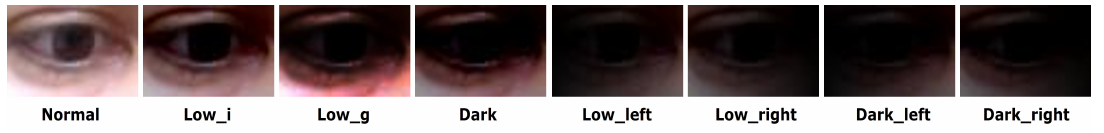
Figure 3. Examples of low and dark illuminated test sets.